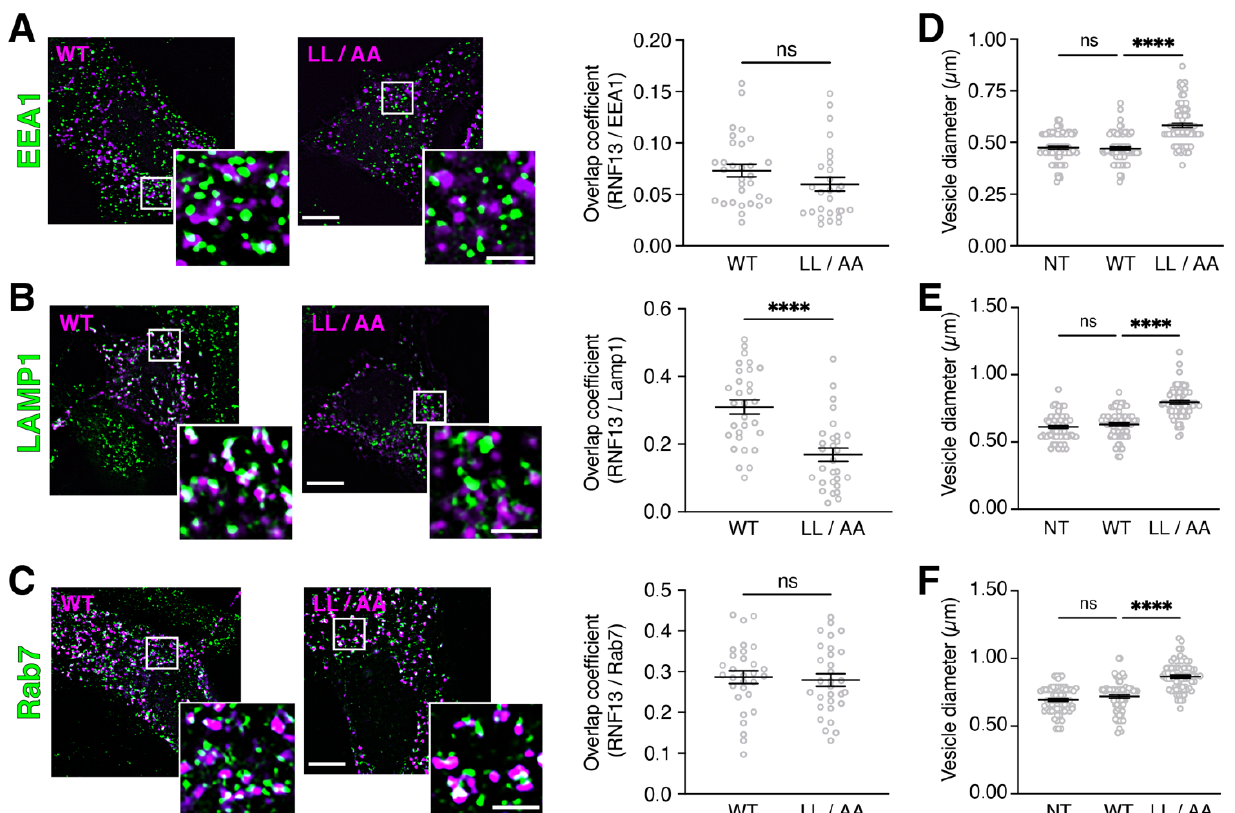
Figure 3. Altered lysosomal targeting of RNF13 L311L312/AA mutant increases the size of endolysosomal vesicles. ( A – C ) Plasmid constructs encoding HA-tagged RNF13 WT or LL/AA were transiently expressed in HeLa cells. Cells were fixed, permeabilized, and labeled with specific primary antibody against HA (RNF13) and against the endogenous subcellular markers. Representative images from three independent experiments (N = 3) show RNF13-HA (in purple) and ( A ) early endosome marker EEA1, ( B ) lysosome marker Lamp1, and ( C ) late endosome marker Rab7 (in green). Scale bars indicate 10 µm for whole cell image and 2 µm for the boxed area shown at higher magnification. The jittered individual value plots ( A – C ) represent Manders overlap coefficient of RNF13 over ( A ) EEA1, ( B ) Lamp1, and ( C ) Rab7. For each condition analyzed: N = 3, n = 30 cells. Values are expressed as mean ± SEM. Not significant (ns) or **** p < 0.0001 using the Mann–Whitney test. ( D – F ) The jittered individual value plots (( D ), EEA1; ( E ), Lamp1; ( F ), Rab7) represent the diameter of the five largest vesicles for each cell. For each condition analyzed: N = 3, n = 15 cells, 75 vesicles. Values are expressed as mean ± SEM. Not significant (ns) or **** p < 0.0001 using one-way ANOVA with the Kruskal–Wallis test.